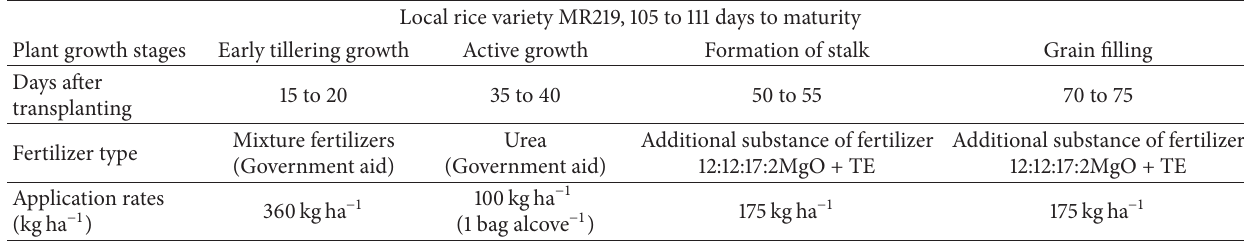
Table 2: Fertilization schedule recommended by Muda Agricultural Development Authority, 2013, and the equivalent rates used in the pot trial.